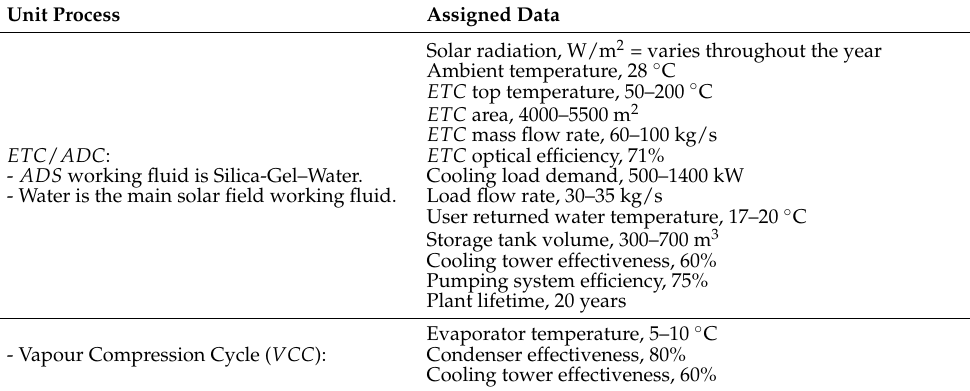
Table 4. Primary assumptions for the proposed solar adsorption cycle and vapour compression cycle systems. The values and parameters are extracted from the following references [23,30–35].